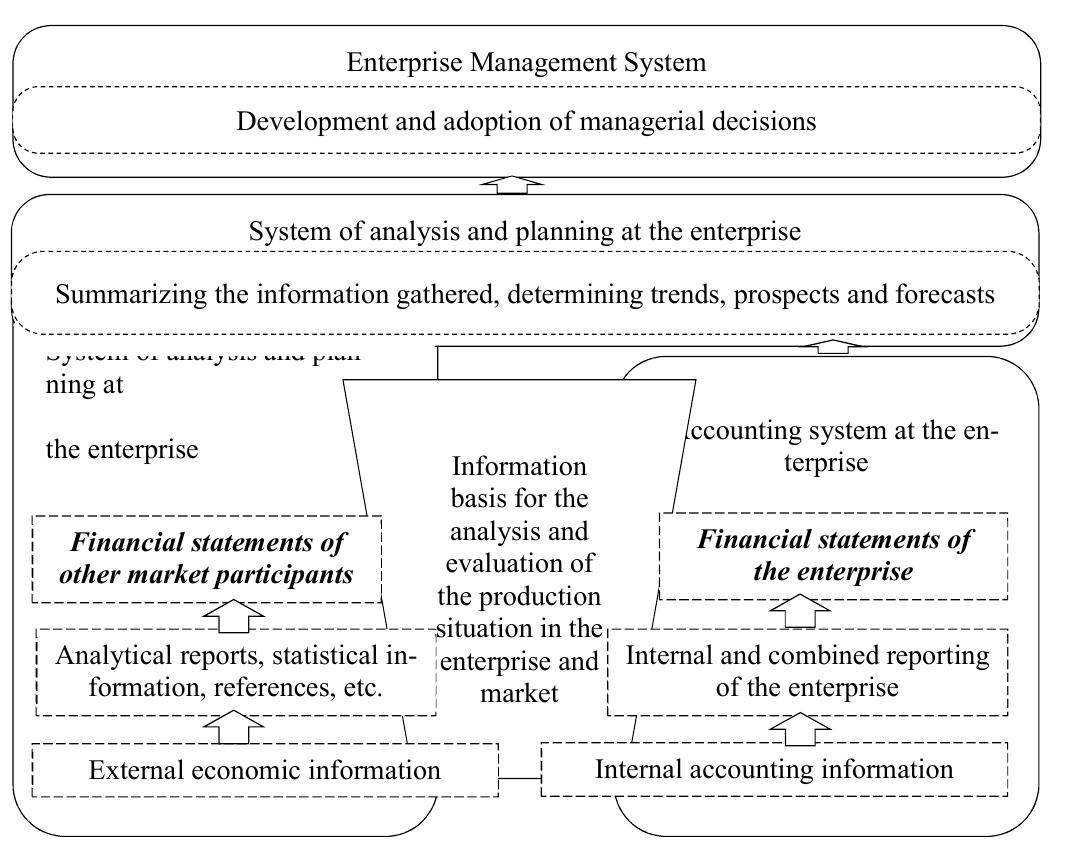
Fig. 5. The role of financial reporting in the process of making managerial